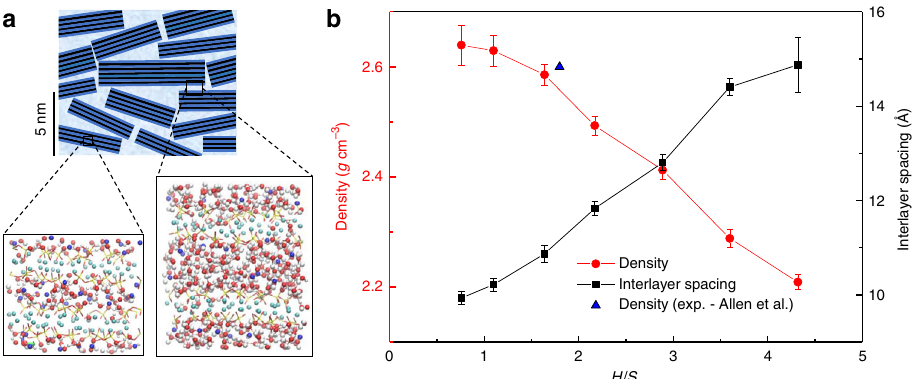
Fig. 4 The impact of the nanocon fi ned water content on the morphology, structure and density of C-S-H. a Schematics of C-S-H globules at the mesoscale shows how atomistic models with varying interlayer water content can potentially correspond to the inter and intraglobular behavior of C-S-H. The black strips represent silicate layers, dark blue is the intralayer or adsorbed water and light blue is the water between nanoglobules of the C-S-H. In the atomistic models, red represents oxygen, blue is interlayer calcium, cyan shows intralayer calcium and white and yellow represent respectively hydrogen and silicon atoms. b Variations of density and interlayer spacing as a function of H / S and comparison with Small Angle Neutron Scattering density